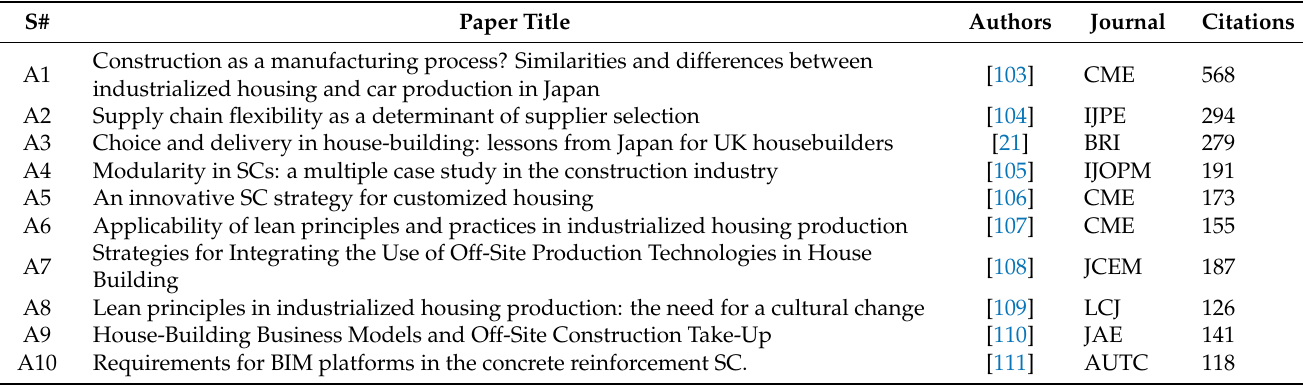
Table 2. Most cited articles (Source Google